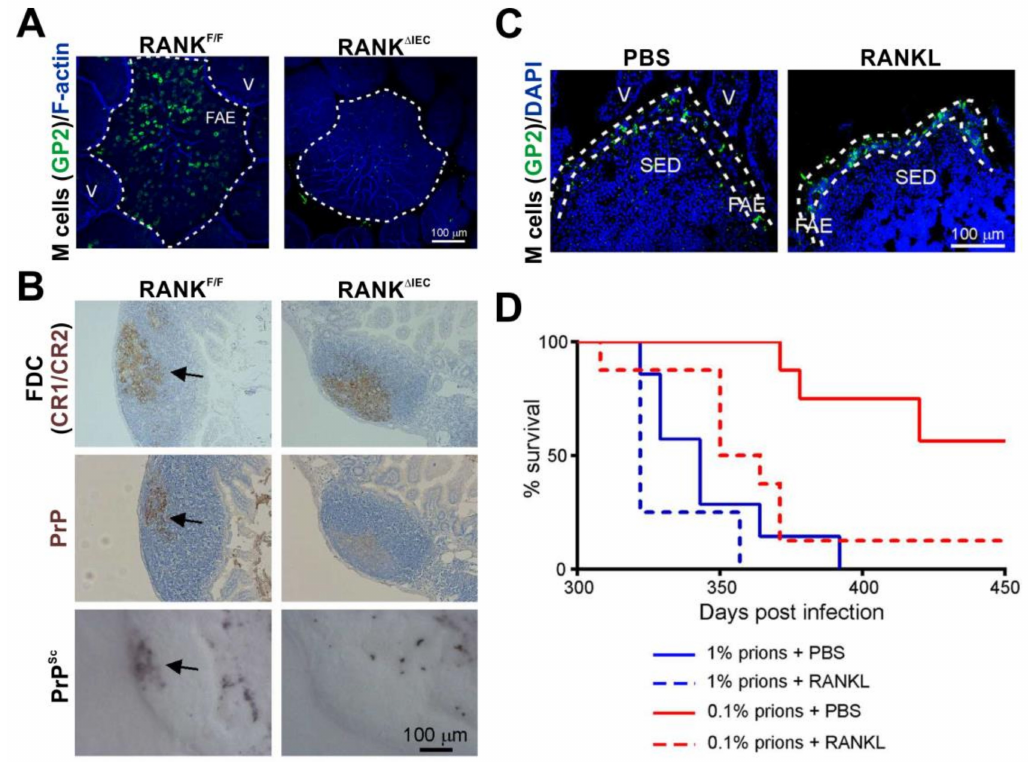
Figure 3. The density of M cells in the epithelia covering the Peyer’s patches directly influences oral prion disease susceptibility [96]. ( A ) Immunofluorescence microscopy shows that RANK ∆ IEC mice specifically lack M cells (GP2 + cells, green) in the follicle-associated epithelia (FAE) of their Peyer’s patches. F-actin, blue. V, villus. ( B ) In the absence of M cells the accumulation of prions (PrPSc, black and PrP, brown, arrows) upon FDC (CR1 / CR2 + cells, brown) in the Peyer’s patches of RANK ∆ IEC mice is blocked. ( C ) Immunofluorescence microscopy shows that systemic treatment of C57BL / 6J mice with the cytokine RANKL increases the abundance of M cells (GP2 + cells, green) in the FAE. DAPI, cell nuclei, blue. SED, subepithelial dome. ( D ) RANKL treatment significantly increases susceptibility to oral prion infection by ~10X. PBS / 1% vs. RANKL / 1%, p = 0.120; PBS / 0.1% vs. RANKL / 0.1%, p < 0.0078; PBS / 1% vs. RANKL / 0.1%, p = 0.205; Log-rank [Mantel–Cox] test). Adapted from [96] under the terms of